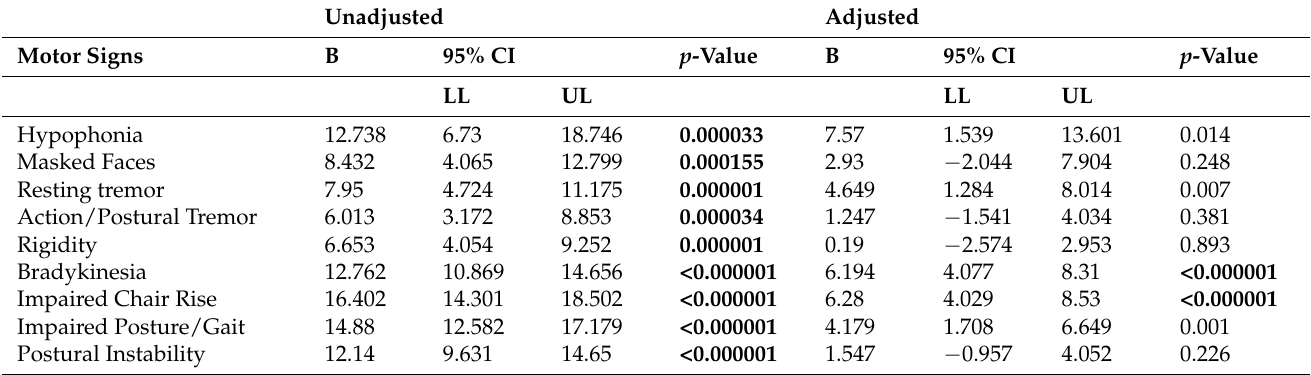
Table 6. Linear regression analysis for association between motor signs and processing speed.